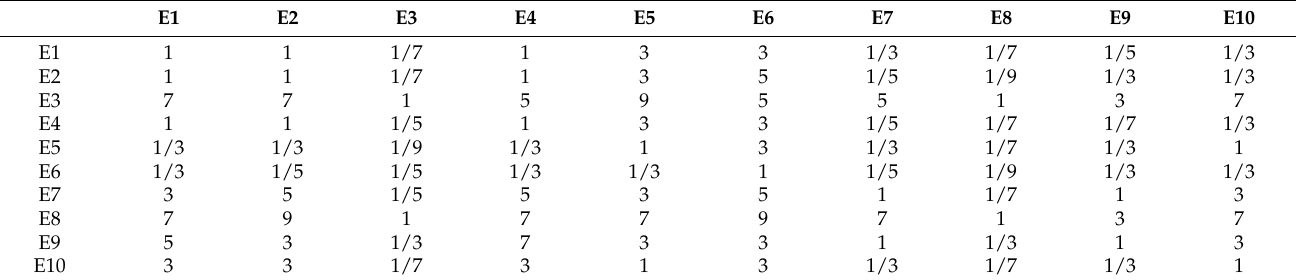
Table A6. Judgment matrix related to detection (D) dimension (Bogn á r and Benedek 2022a).